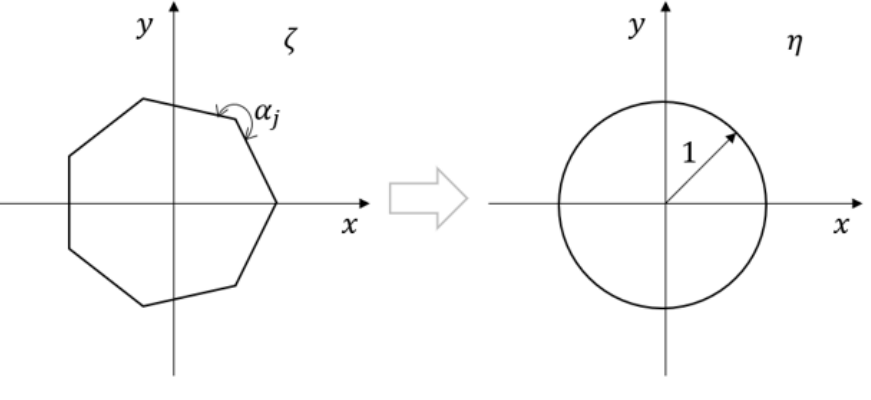
Figure 2. A schematic diagram of conformal mapping.